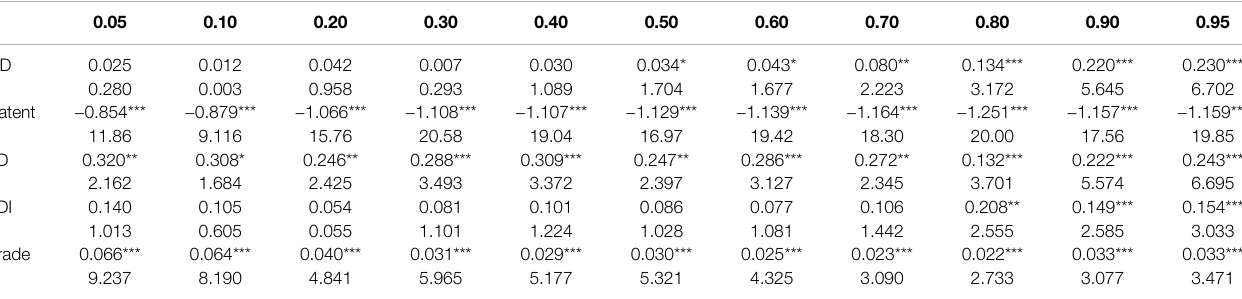
TABLE 5 | Panel quantile regression of CO 2